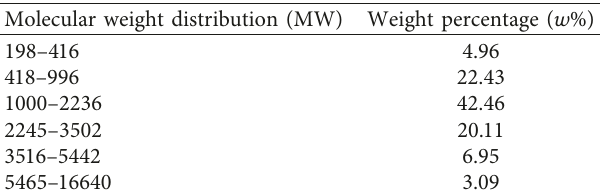
Table 2: The molecular weight distribution of yak skin gelatin